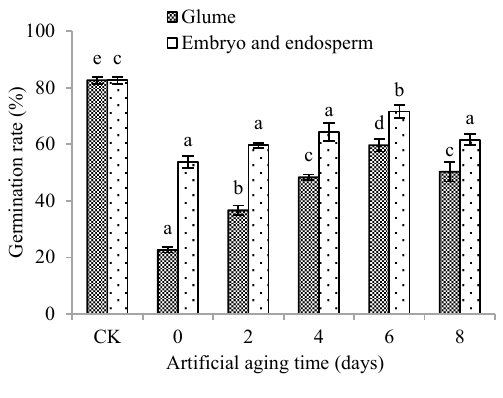
Figure 5 Effect of water extract from glume, embryo, and endosperm of Aegilops tauschii on the germination percentage of cabbage seeds. e values are shown as mean ± SE . Different letters above the bars denote significant differences ( p ≤ 0.05) with Duncan’s test within the same planting conditions.